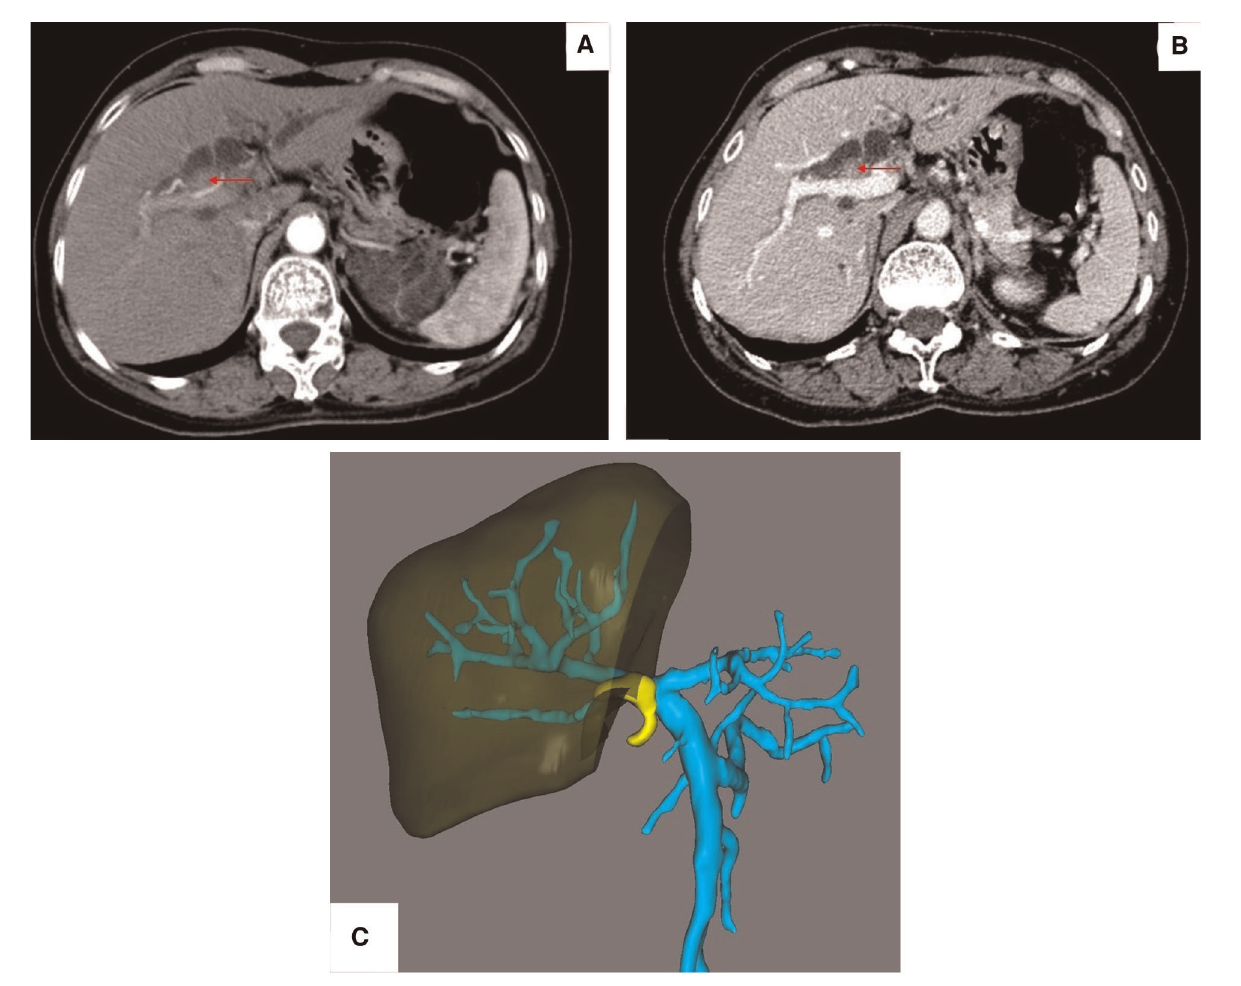
FIGURE 1 | ( A ) CT revealed a 10×17 mm space-occupying lesion (red arrow) in the hepatic hilum with an unclear boundary. ( B ) Tumor (red arrow) showed obvious enhancement. ( C ) Postoperative left residual volume was estimated to be only